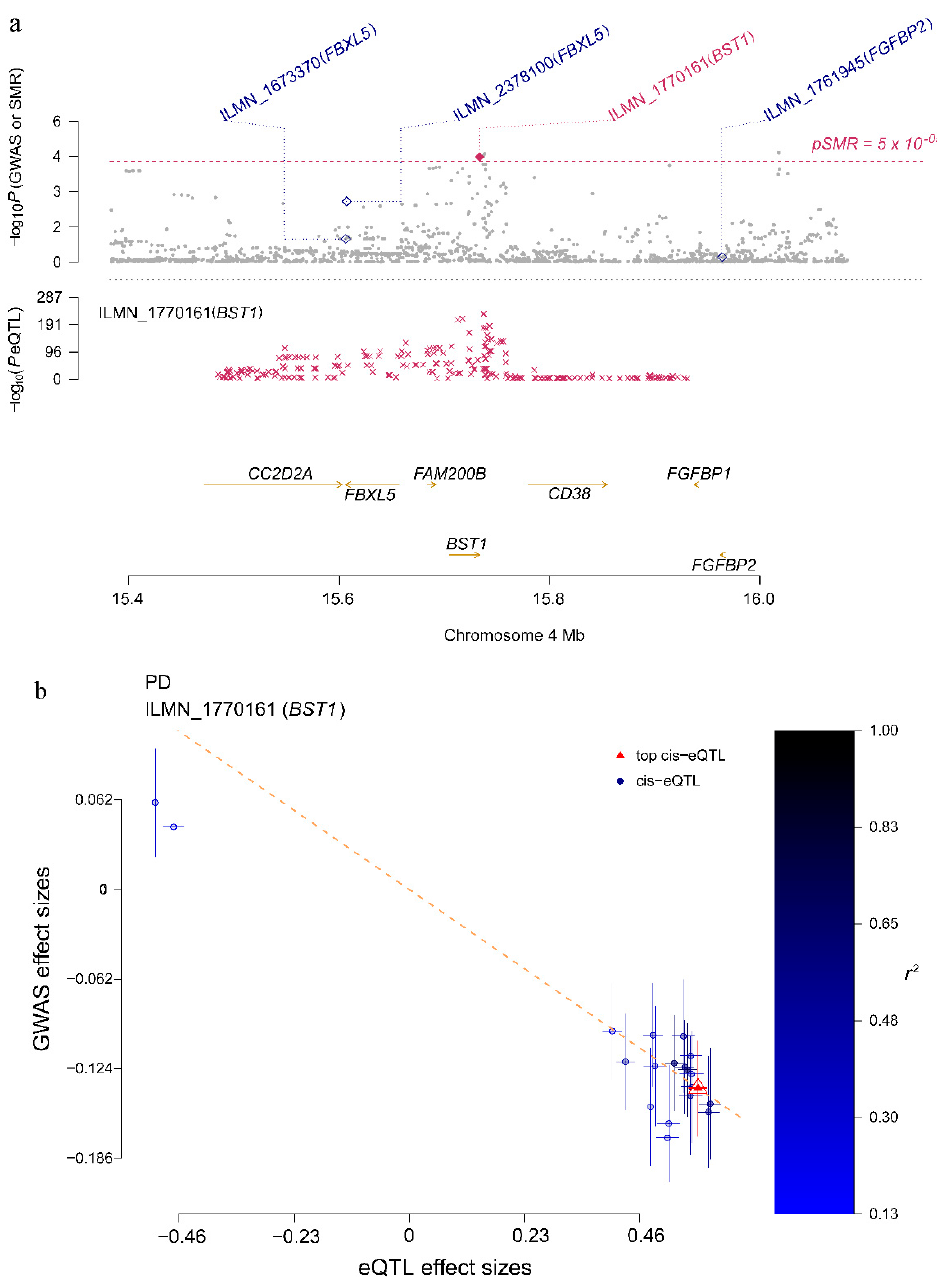
− 229 of 1.01 × 10 (Figure 5a). In addition, according to the e ff ect value of eQTL ( b zx = 0.58) and the e ff ect value of the SNP in the GWAS of the phenotype ( b zy = − 0.14), SMR estimates that b xy = − 0.24 can